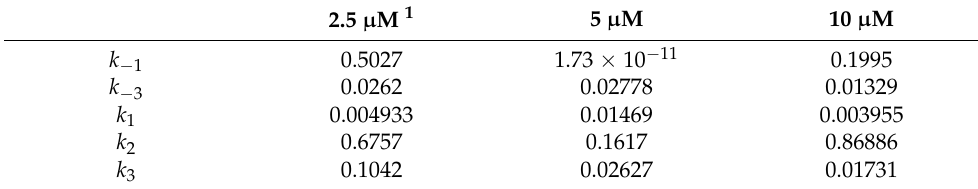
1 ADP concentrations for the corresponding experimental